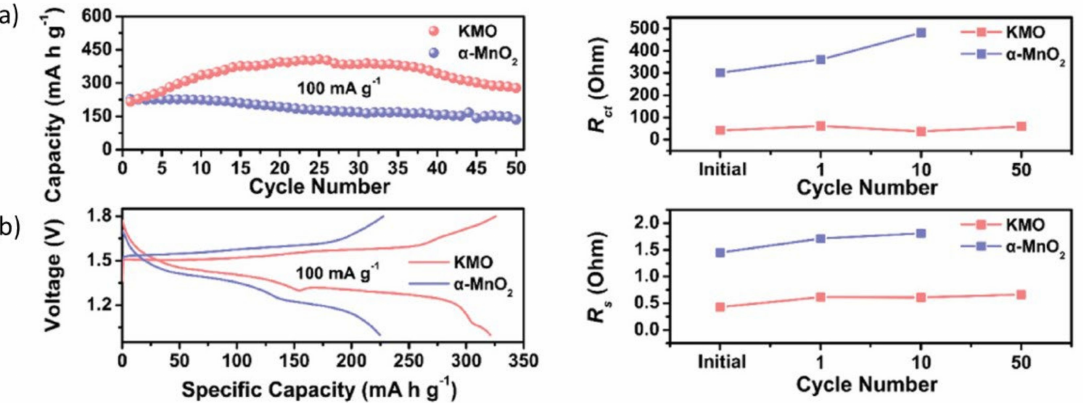
Figure 8. ( a ) Cycling performance at 100 mA g − 1 and corresponding galvanostatic charge/discharge curves at the tenth cycle. ( b ) Plots of electrolyte resistance, Rs, and charge-transfer resistance, Rct. Reprinted with permission from Ref. [69]. Copyright 2019